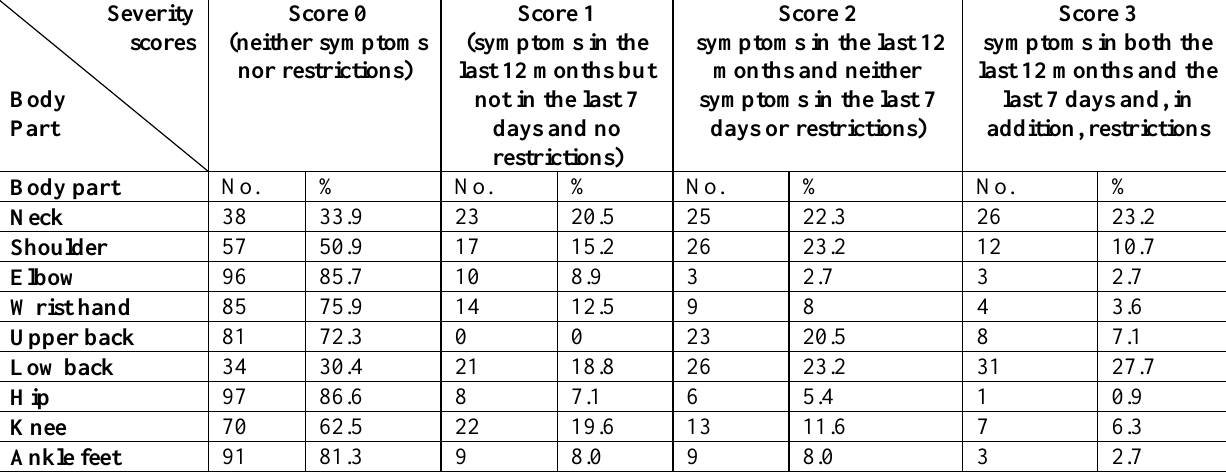
Table 3: Distribution of the dentists according to musculoskeletal complaints severity score by body